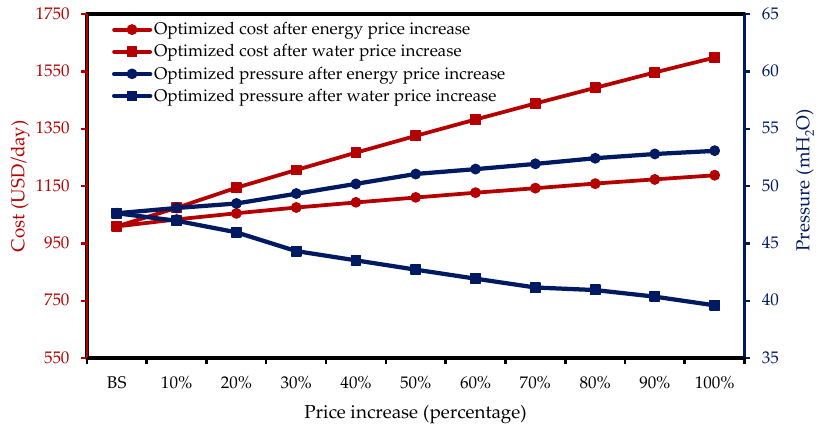
Figure 7. Sensitivity of optimized pressure and cost to water and energy price increase.